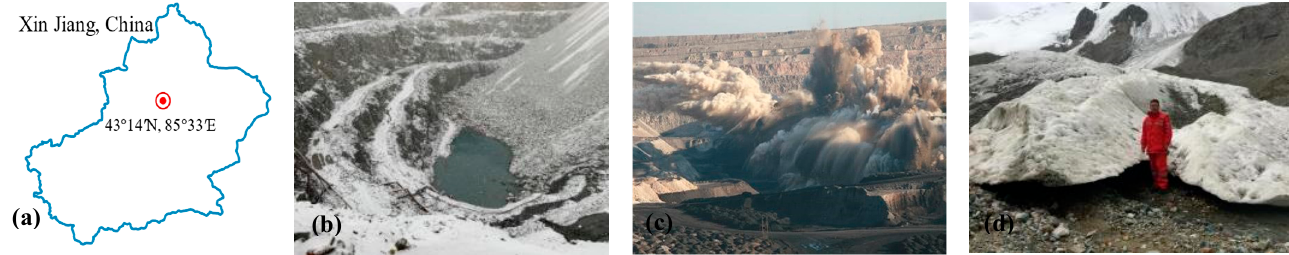
Figure 3. Actual situation of the study area. ( a ) Geographical location of the Beizhan iron mine and glacier. ( b ) Open-pit mining. ( c ) Dust diffusion. ( d ) Glacier ablation.